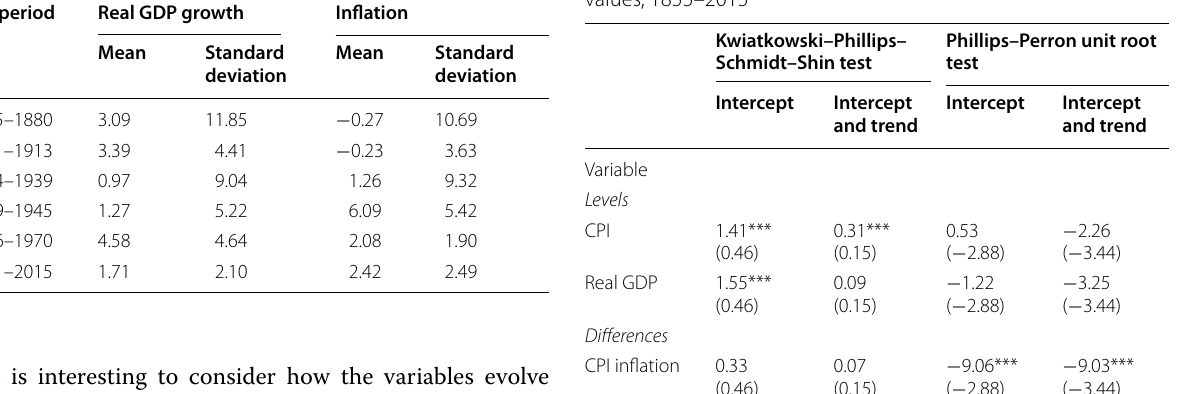
Table 2 Unit root and stationarity tests, statistics and 5% critical values,